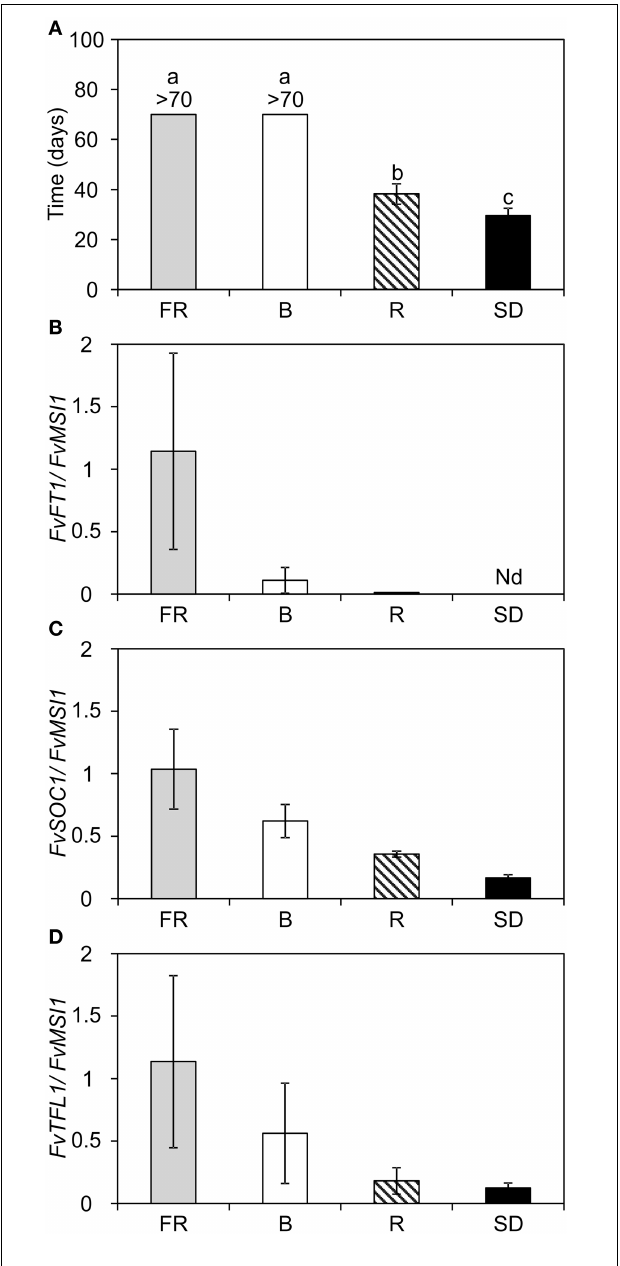
FIGURE 5 | Flowering time and the expression of flowering time genes in the SD F. vesca subjected to end-of-day light quality treatments. (A) Flowering time of the SD F. vesca indicated as days to anthesis after the light quality treatments ( n = 14). Flowering results were subjected to One-Way ANOVA ( t -test), p < 0 . 001 for the treatment. Different lower-case letters indicate significant differences between the treatments according to Tukey’s pairwise test, α = 0 . 05. (B) The expression of FvFT1 in the leaf samples, and (C) FvSOC1 and (D) FvTFL1 in the shoot apex samples 4 weeks after the beginning of the light quality treatments. Plants with 5–6 open leaves were subjected to 12-h short-day (SD) or 12-h SD plus 6-h low intensity (15 μ mol m − 2 s − 1 ) end-of-day treatment with blue, far-red or red light (B, FR, or R, respectively) at 18 ◦ C for 8 weeks. For gene expression data, three biological replicates were analyzed by real-time PCR. Shoot apex and leaf samples were collected 4 and 16h after dawn, respectively. All results are mean ± SD . Nd, not